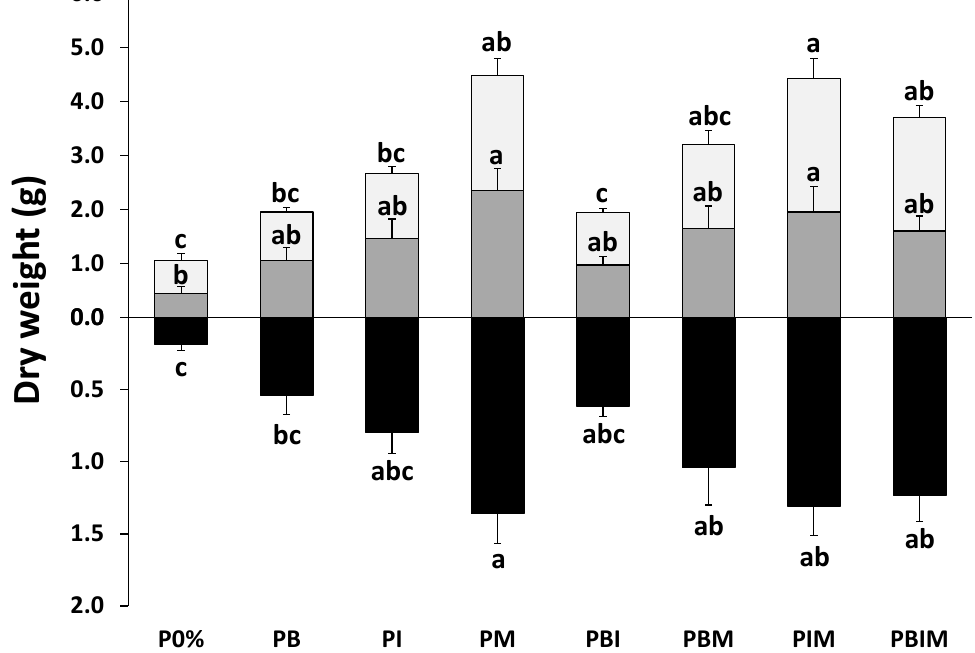
Figure 2. Dry weight (g) of roots (black box), stems (dark grey box) and leaves (light grey box) determined after 60 days of Salix triandra growth (T60) in the eight studied treatments. Different letters indicate significant difference among the treatments ( p < 0.05) ( n = 5). The letter “a” is used for the highest value found. Different treatments with at least one letter in common show no significant difference. Thus, different treatments not having any letter in common are significantly different from each other. P0%—Pontgibaud technosol; PB—Pontgibaud amended with 1% biochar;